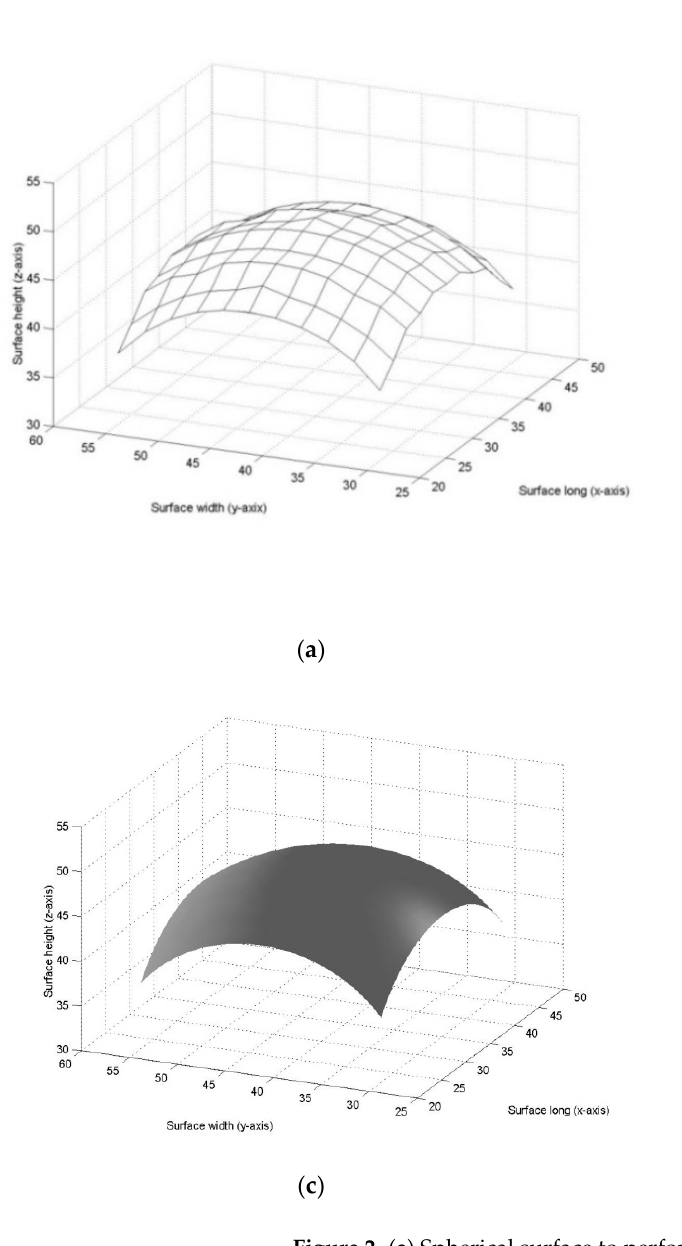
Figure 2. ( a ) Spherical surface to perform spherical surface modeling. ( b ) Flowchart of the genetic algorithm to determine spherical surface model. ( c ) Spherical surface provided by the surface model in Equation (1).